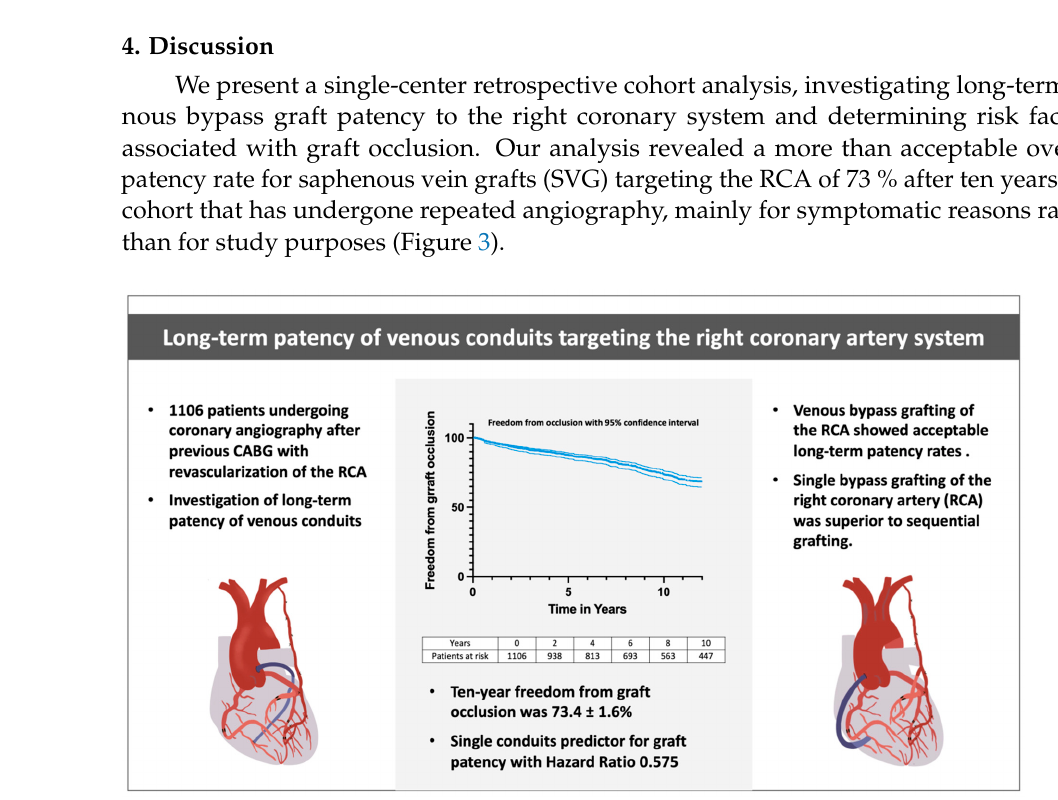
Figure 3. Overview of the study rationale, important findings, and conclusion. The overall freedom from graft occlusion is depicted as the central figure. Representative figures of mixed revascularization with a sequential venous conduit on the left and a single venous conduit to the right coronary artery on the right